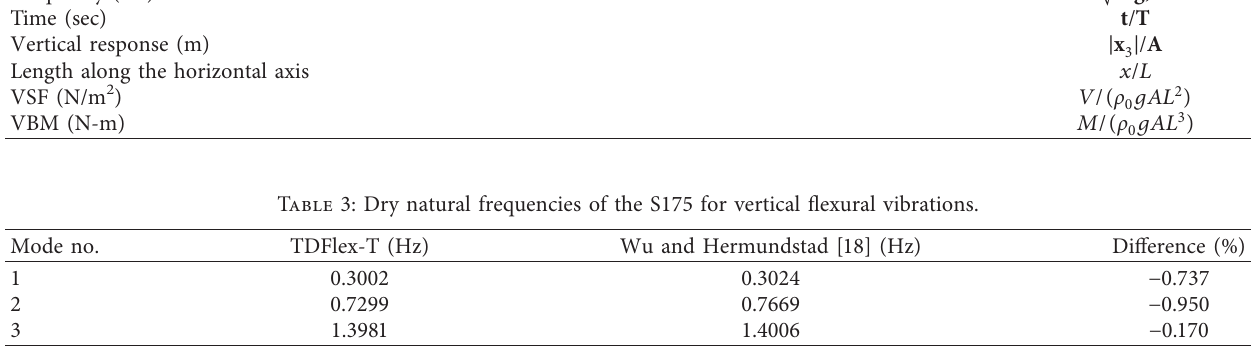
� 0 . 25, λ / L � 1 ) . (a) VBM time history, S175. (b) VSF time n